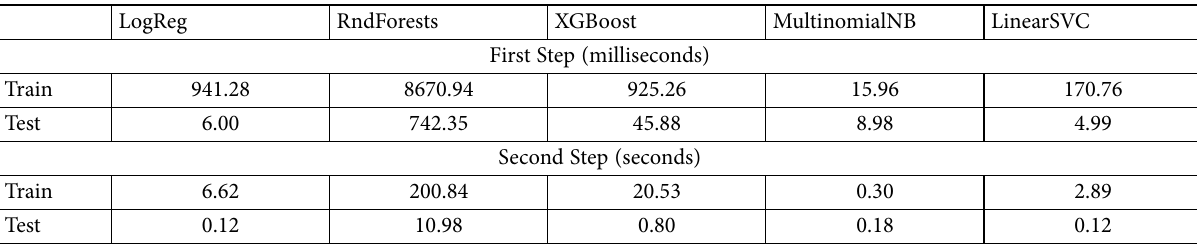
Table 8. Train/Test runtime of the used